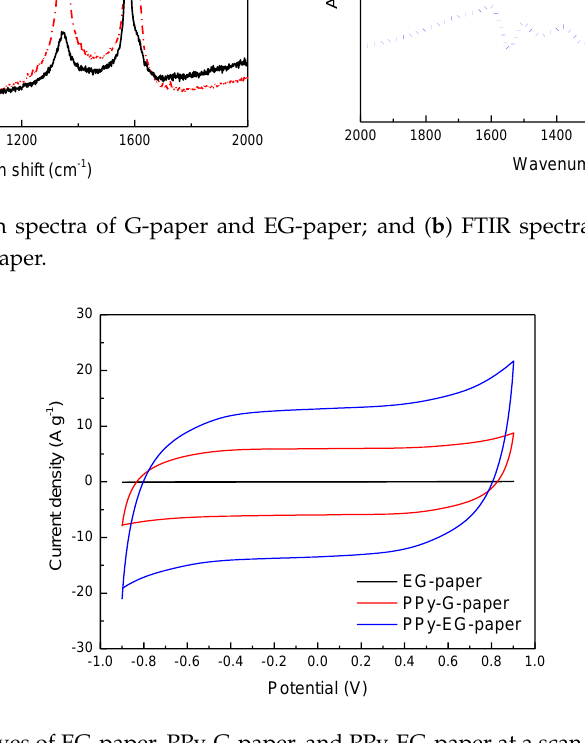
Figure 4. ( a ) Raman spectra of G-paper and EG-paper; and ( b ) FTIR spectra of the blank paper, EG-paper, PPy-EG-paper.